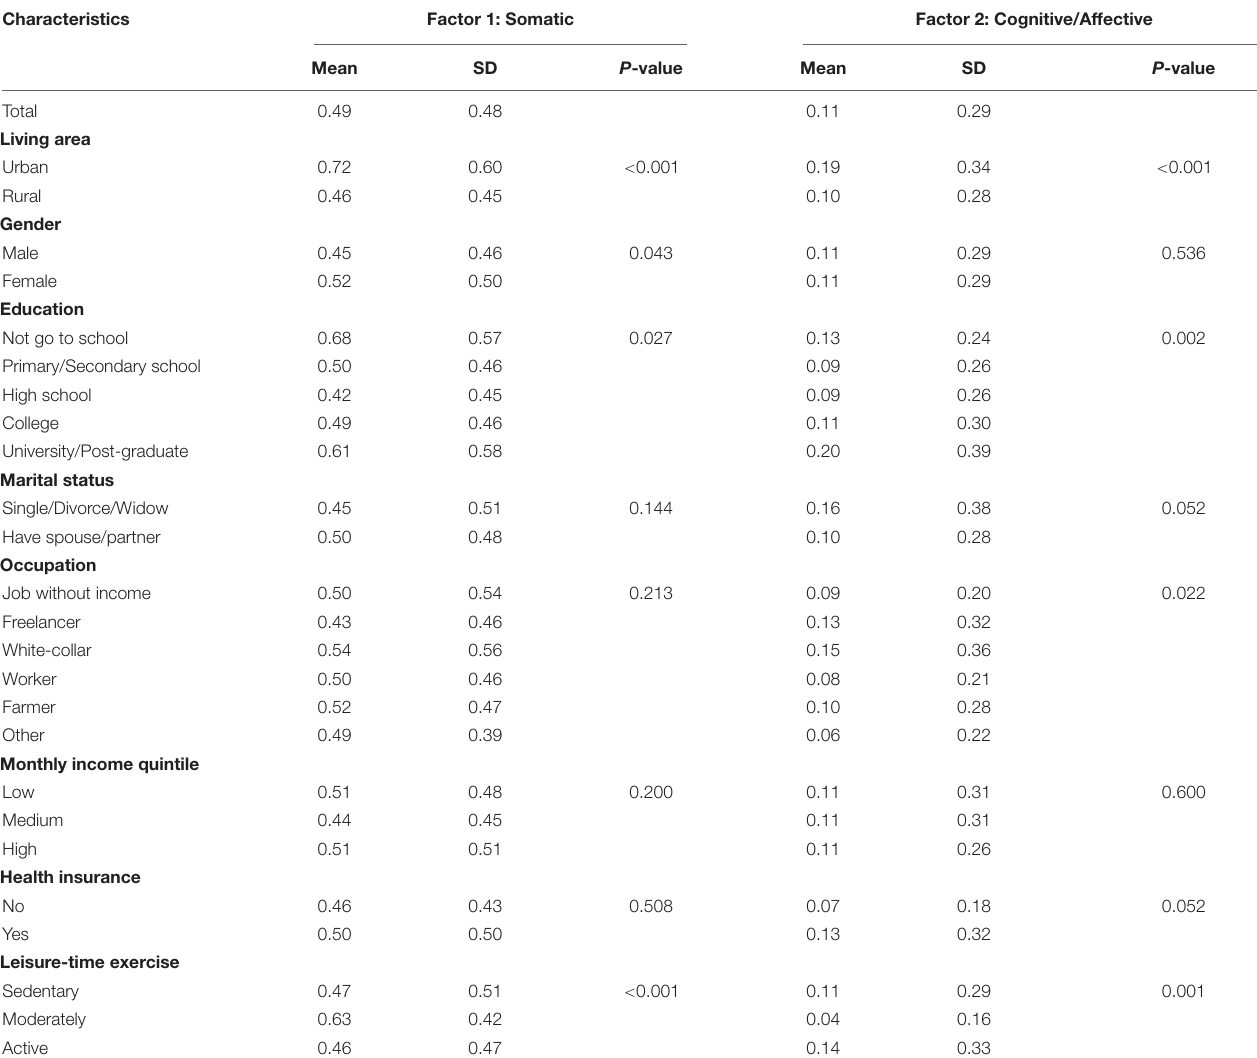
TABLE 5 | Patient Health Questionnaire (PHQ-9) - factors scores by different characteristics. Characteristics Factor 1: Somatic Factor 2: